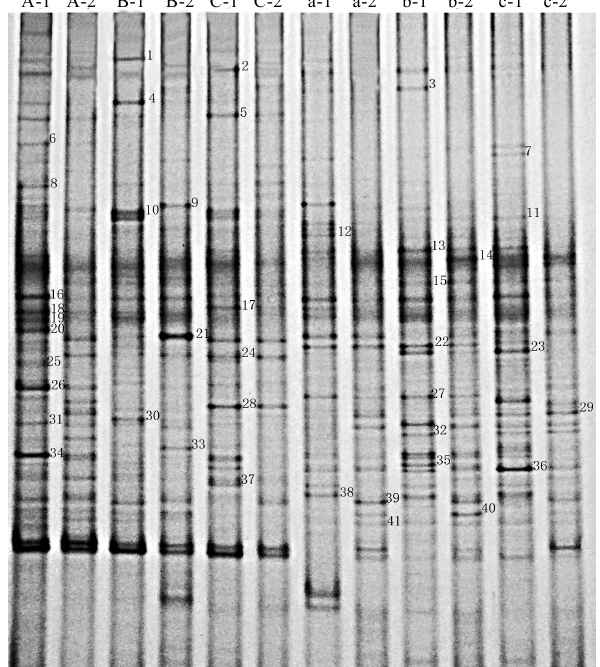
Figure 3. Denaturing gradient gel electrophoresis (DGGE) profile of 16S rDNA V3 fragments amplified from a microbial community of three wetlands. (Note: A-1, A-2, B-1, B-2, C-1 and C-2 were substrate samples before adding DMP in the three constructed wetlands (CWs). The samples of a-1, a-2, b-1, b-2, c-1, and c-2 were substrate samples after adding DMP in the three CWs. In the sample code, the uppercase English letter refers to the sample before adding DMP, and the lowercase letter refers to the sample after adding DMP (the letters A and a represent the wetland A of planted Pennisetum sinese Roxb; B and b represent the wetland B of planted Pennisetum purpureum Schum.; C and c represent the blank control wetland C; the Arabic numerals represent the sampling depth: 1 represents the upper substrate of 0–40 cm, and 2 represents the lower layer substrate of 40–80 cm. Serial numbers correspond to bands excised from the DGGE and sequenced results are listed in Table 1).